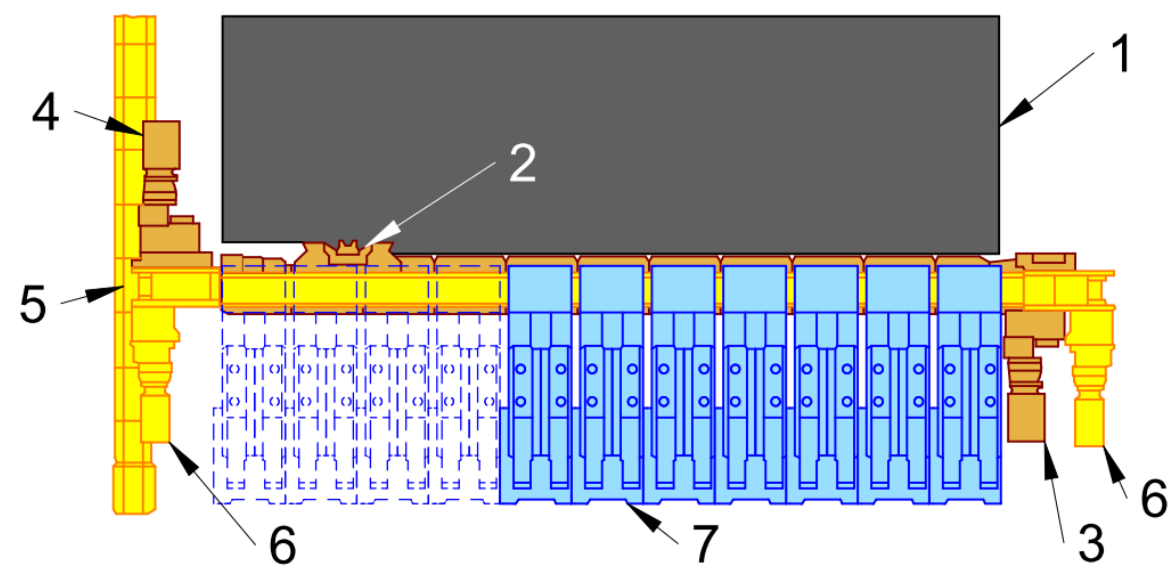
Figure 1. Schematic of a longwall coal plough system. 1—coal panel, 2—plough head, 3—plough main drive, 4—plough secondary drive, 5—armored-face conveyor, 6—conveyor drives, 7—powered roof supports.